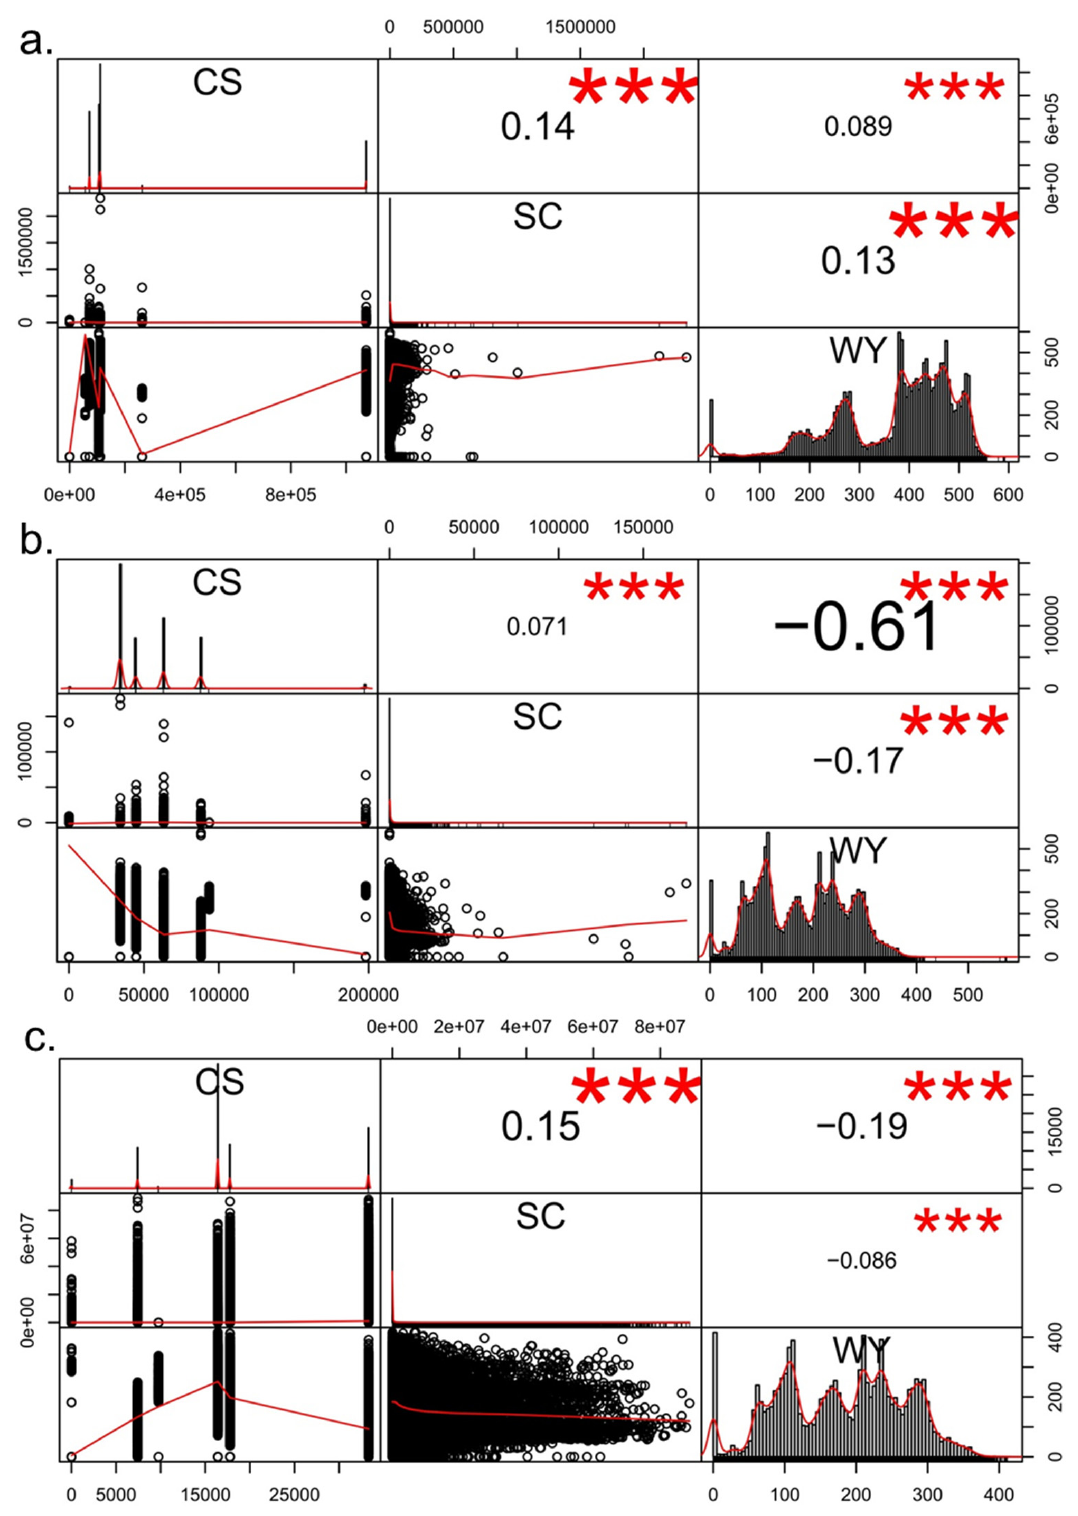
Figure 6. Relationship between the three ecosystem services in different scenarios. The number of * in the figure is significant level of correlation. CS: carbon storage; SC: soil conservation; WY: water yield. ( a ) conservation scenario; ( b ) development scenario; ( c ) natural scenario.